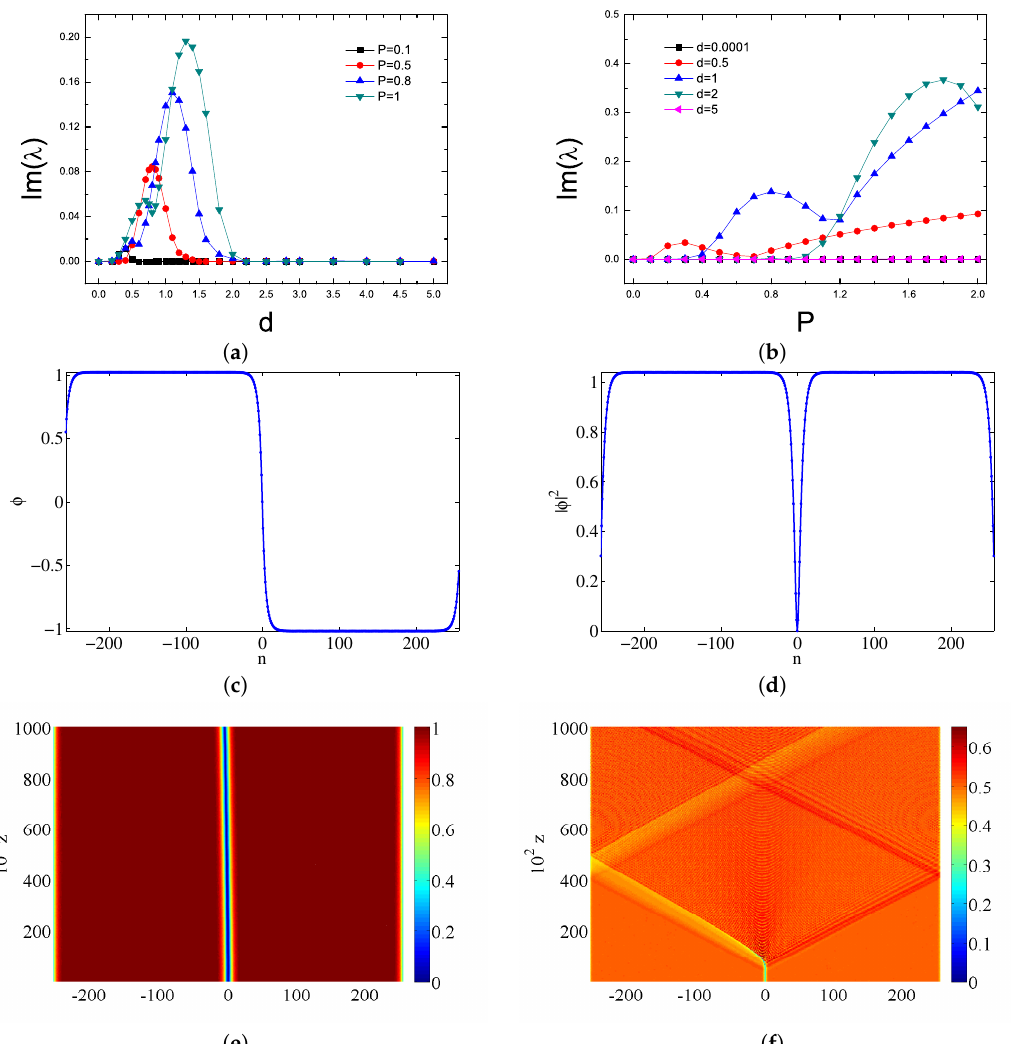
Figure 1. Dark solitons in a 513-waveguide array. ( a ) The imaginary part of the eigenvalues λ (Im( λ )) for different d values; ( b ) The imaginary part of the eigenvalues λ (Im( λ )) for different P values; ( c ) The amplitude of the fundamental solution for dark solitons ( P = 1 and d = 3); ( d ) The intensity of the fundamental solution for dark solitons ( P = 1 and d = 3); ( e ) The evolution of a stable solution for dark solitons ( P = 1 and d = 3); ( f ) The evolution of an unstable solution for dark solitons ( P = 0.5 and d = 0.8).